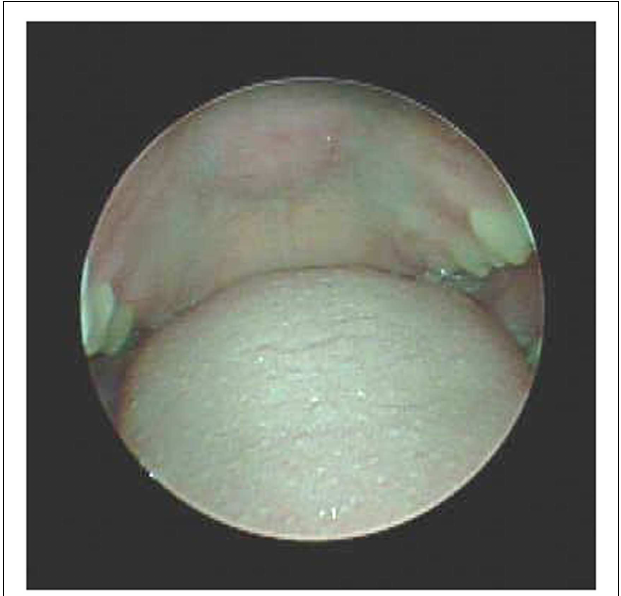
FIGURE 1 | Pre-operative view of palate, Mallampati 4 .